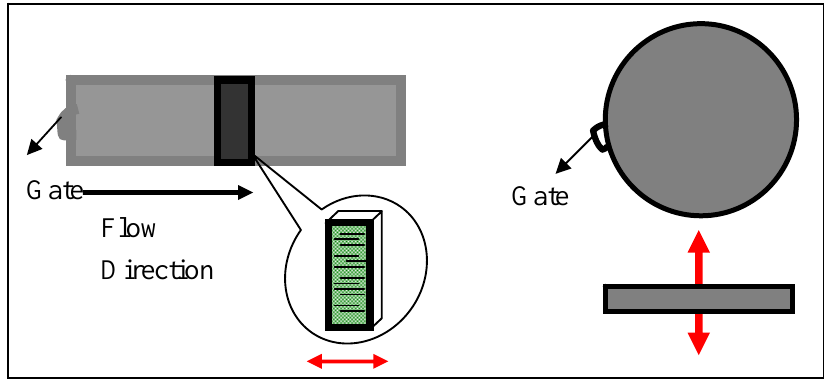
Figure 5. Schematic of molds used to explore the effect of xGnP anisotropy. The red arrow shows the direction of measurement (a) along the flow direction, parallel to the graphite plane and (b) normal to the flow, parallel to graphite